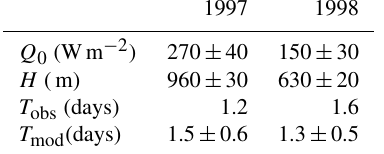
Table C2. Time of “emergence from noise” t E (year-day),